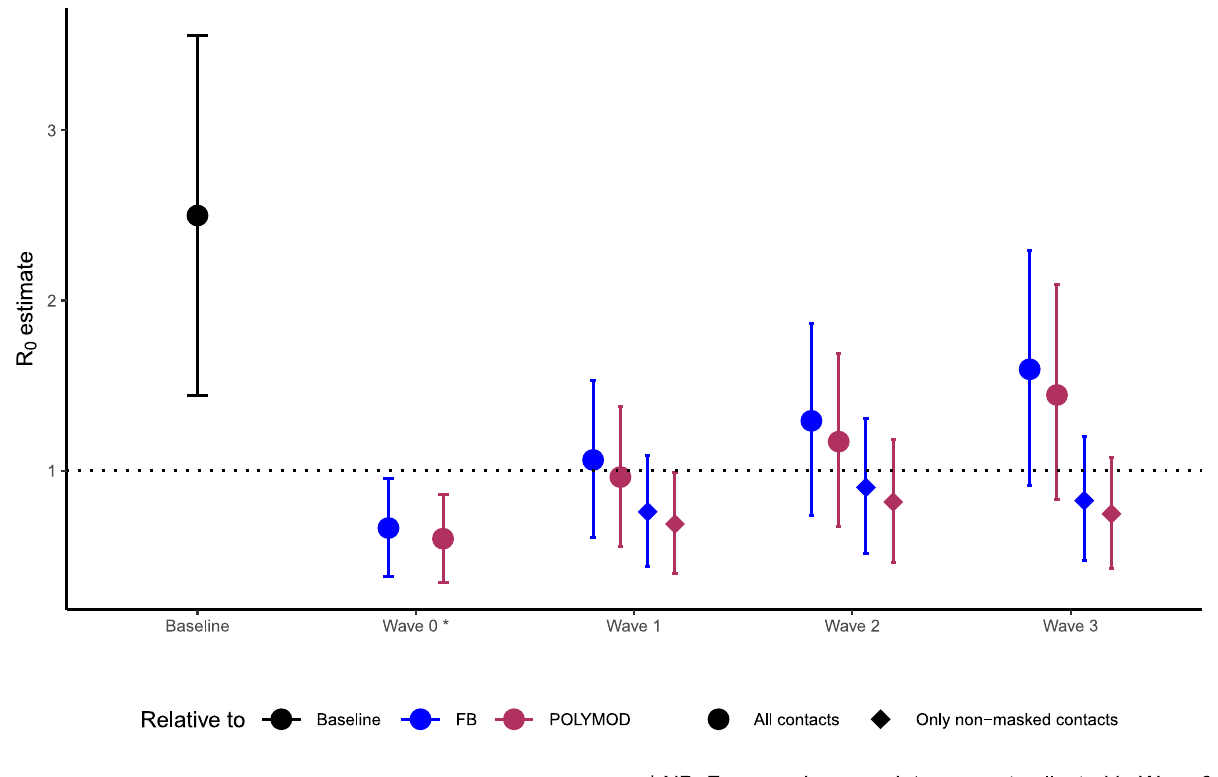
Fig. 4 Implied R 0 estimates for each wave. The implied R 0 from the BICS contact matrices for each wave relative to two baseline contact matrices from the 2015 study and the UK POLYMOD study, and assuming a baseline R 0 value drawn from a normal distribution with mean 2.5 and standard deviation of 0.54. Circles indicate R 0 estimates calculated from age-structured contact matrices for all reported contacts ( n = 3163 in Wave 0, n = 7473 in Wave 1, n = 7842 in Wave 2 and n = 11, 402 in Wave 3); diamonds indicate R 0 estimates calculated from age-structured contact matrices for contacts where no mask usage was reported ( n = 5777 in Wave 1, n = 5818 in Wave 2 and n = 7583 in Wave 3). Ninety- fi ve percent con fi dence intervals were derived from the bootstrap. FB: 2015 Facebook